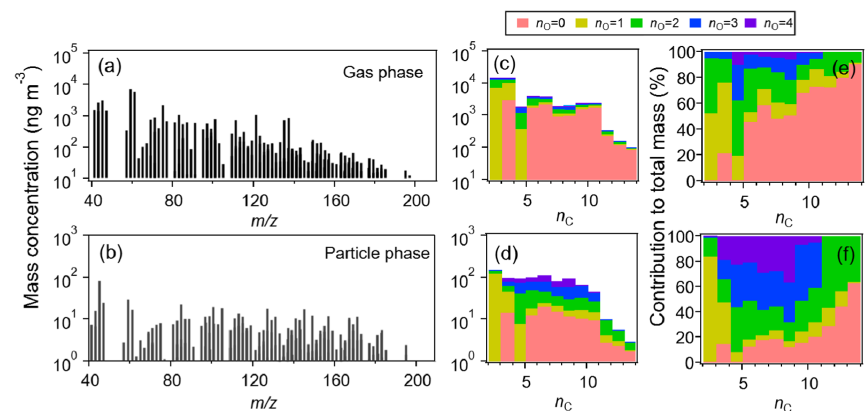
Figure 3. Background subtracted monthly-average PTR-ToF-MS mass spectra in the (a) gas phase and (b) particle phase. Mass distributions of all identified species resolved by the carbon and oxygen numbers ( n C and n O ) in the (c) gas phase and (d) particle phase, as well as their relative contribution to the total organic mass in the (e) gas phase and (f) particle phase.